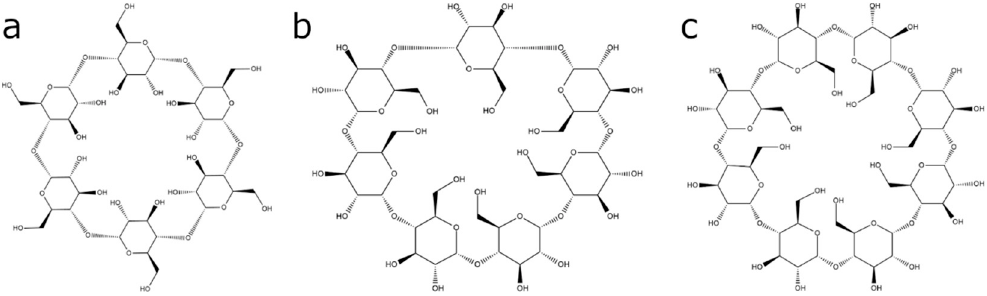
Figure 1. Chemical structure of ( a ) α -cyclodextrin, ( b ) β -cyclodextrin, and ( c ) γ -cyclodextrin.